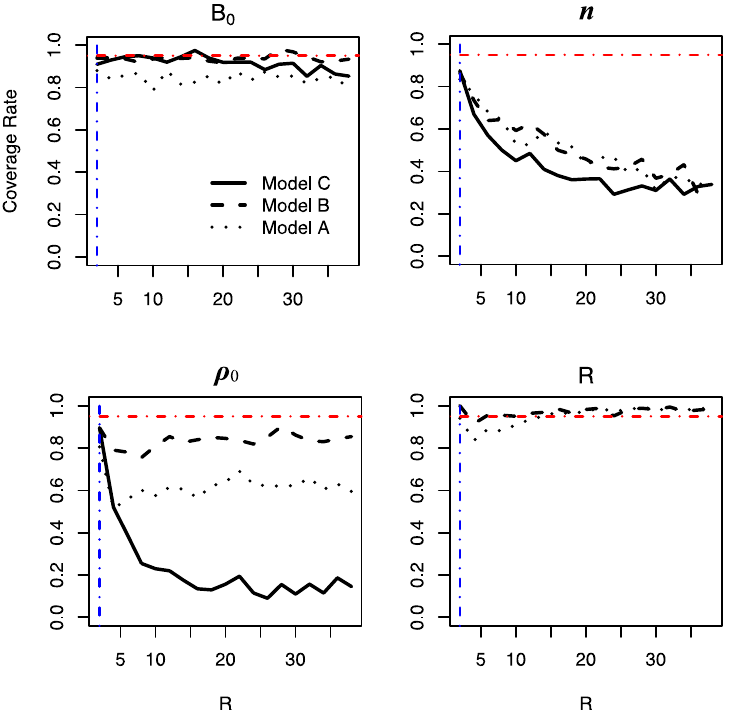
Figure 2. Coverage rate of the 95% HPDI of each parameter under different uncertainties (R) of ρ [5]. The red dash line corresponds to the target coverage rate of 95%, while the blue dash line marks R = 2. Model B (see the text) has the best estimates of B 0 , ρ 0 , and R; however, the index n is not estimable by any model when R > 2.